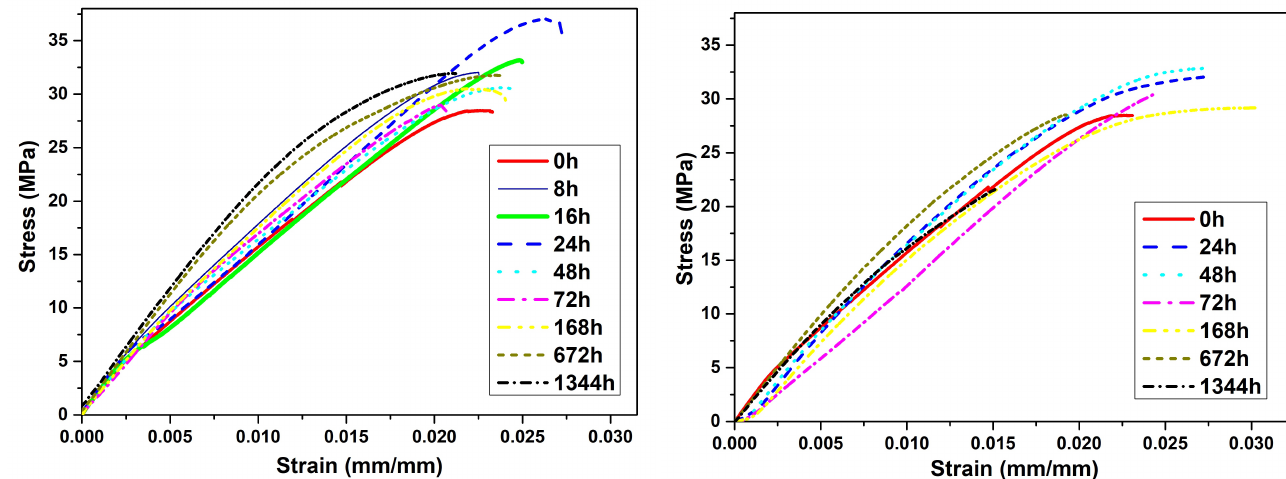
Figure 4. Stress–strain curves after thermal aging ( left ) and hydrothermal aging ( right